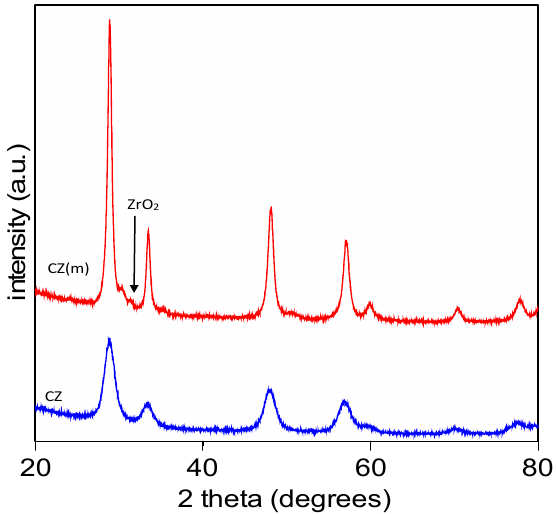
Figure 1. XRD profile for ceria–zirconia before and after high energy milling.